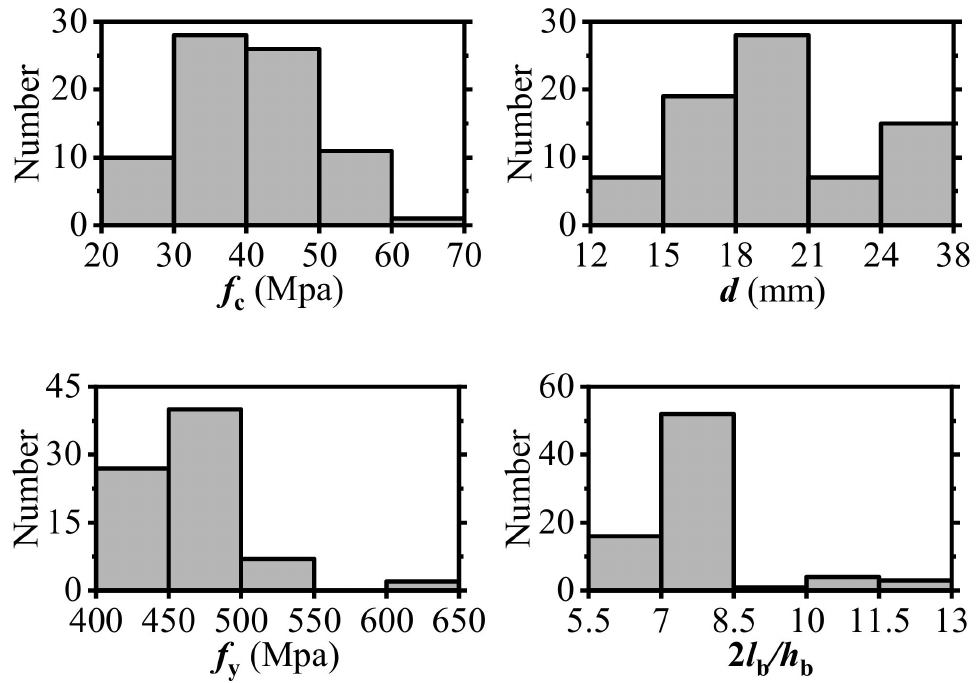
Figure 8. Parameter statistics of the selected